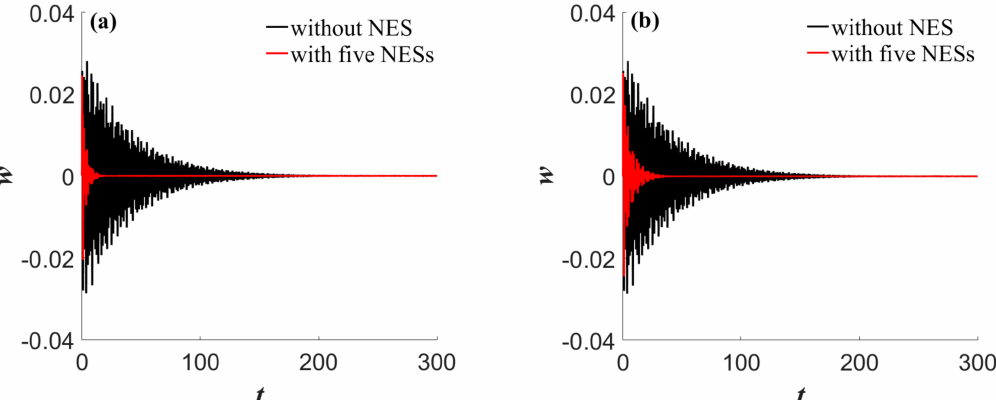
Figure 4. Comparison of vibration-reduction performance of five NESs under different locations: ( a ) the responses when ( a 2 = 0.3, b 2 = 0.3 ) ; ( b ) the responses when ( a 2 = 0.18, b 2 = 0.18 ) . In the third step, keep the shock amplitude f = 5 and change the location of the force on ( p 1 = 0.5, p 2 = 0.5 ) and ( p 1 = 0.5, p 2 = 0.3 ) . From Figure 5a,b and Figure 3c, it is